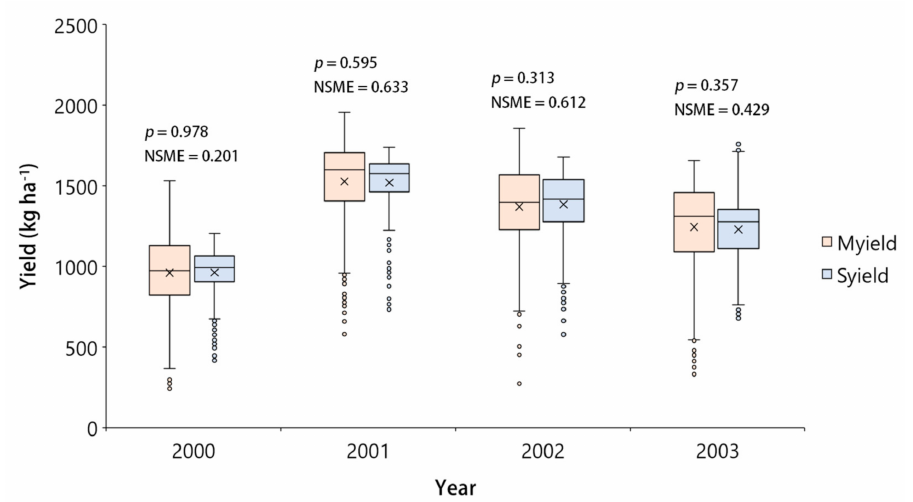
Figure 7. Box and whisker plots comparing p values according to the t -test ( α = 0.05) and Nash– Sutcliffe model efficiency (NSME) values for the simulated (S) and measured (M) cotton lint yields of field #26 over time. Error bars and boxes represent the 10th, 25th, 75th, and 90th percentiles of the yield data, showing the median (solid line) and mean ( × ), where circles indicate